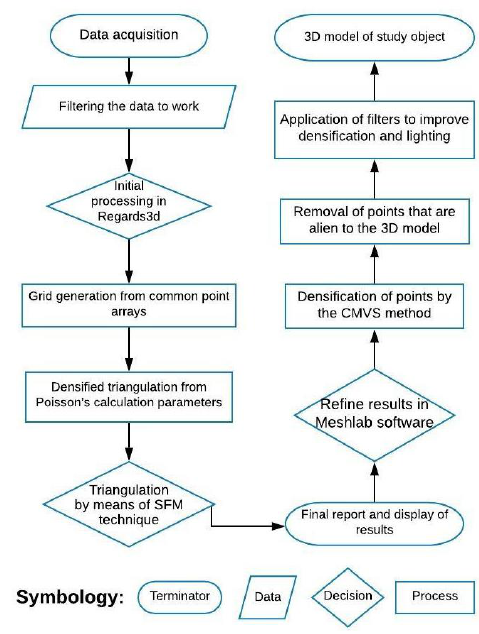
Figure 5. Methodology used for the 3D model of the La Rebeca Monument.